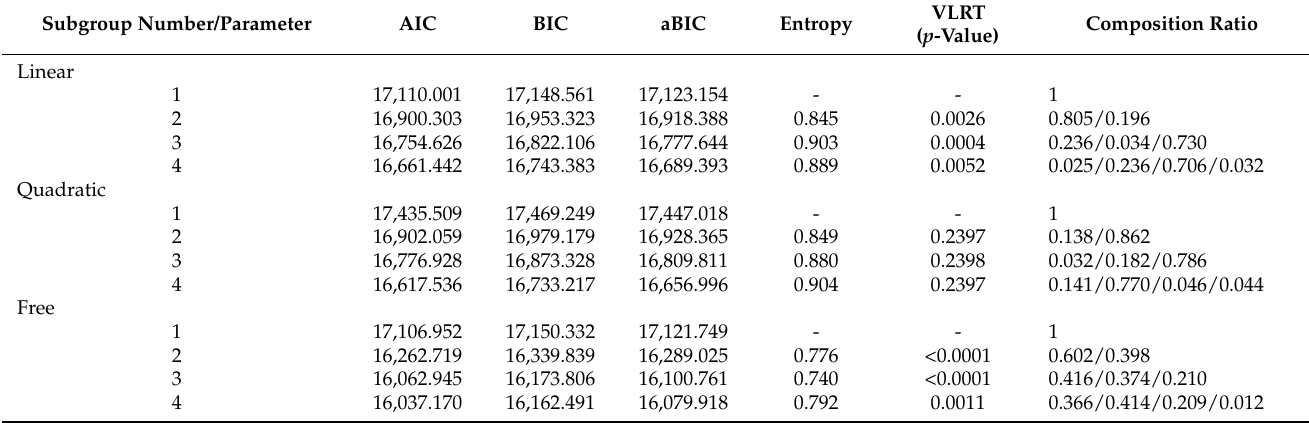
Table A2. GMM fitting statistics results (prenatal anxiety).